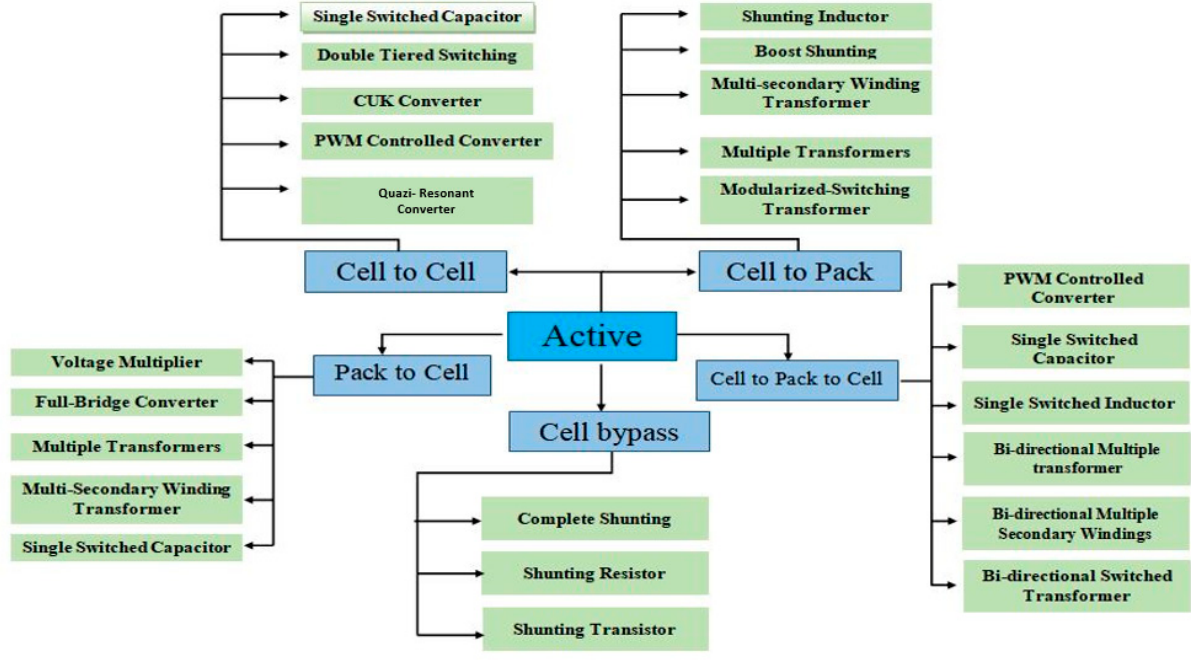
Figure 7. Active balancing topologies [6].